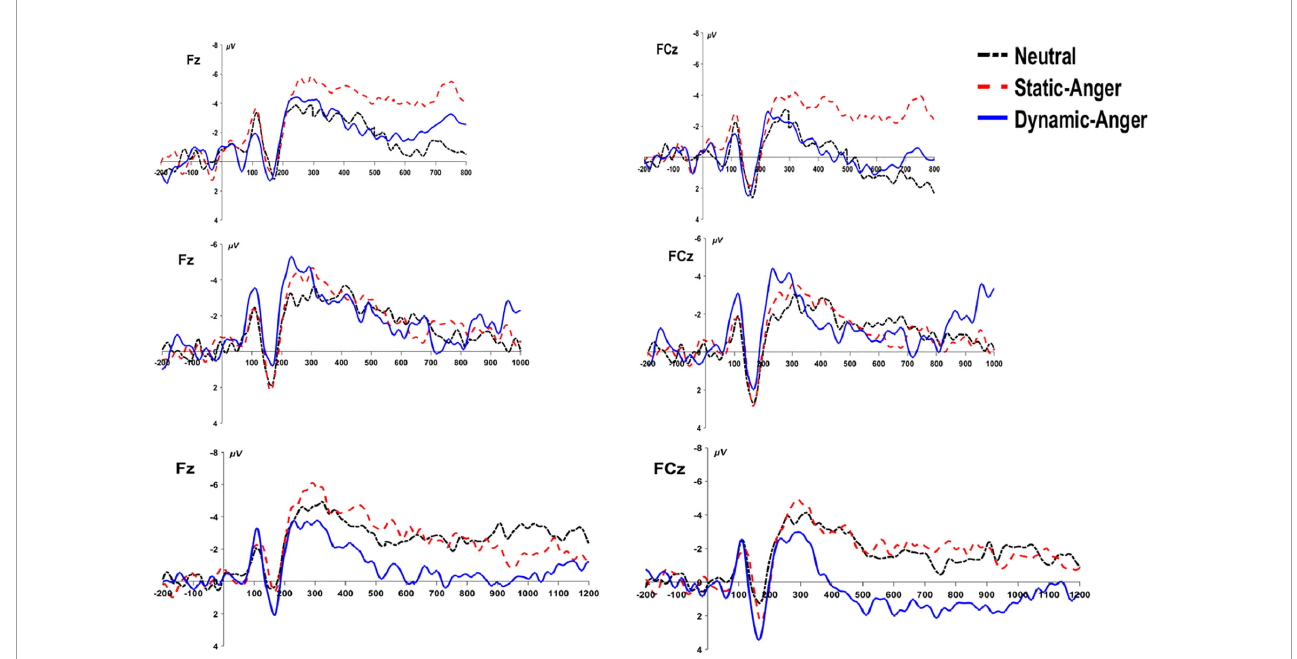
FIGURE7 The grand-mean ERP waveforms of the CNV component at Fz and FCz under the three different duration conditions (800, 1000, and 1200 ms).